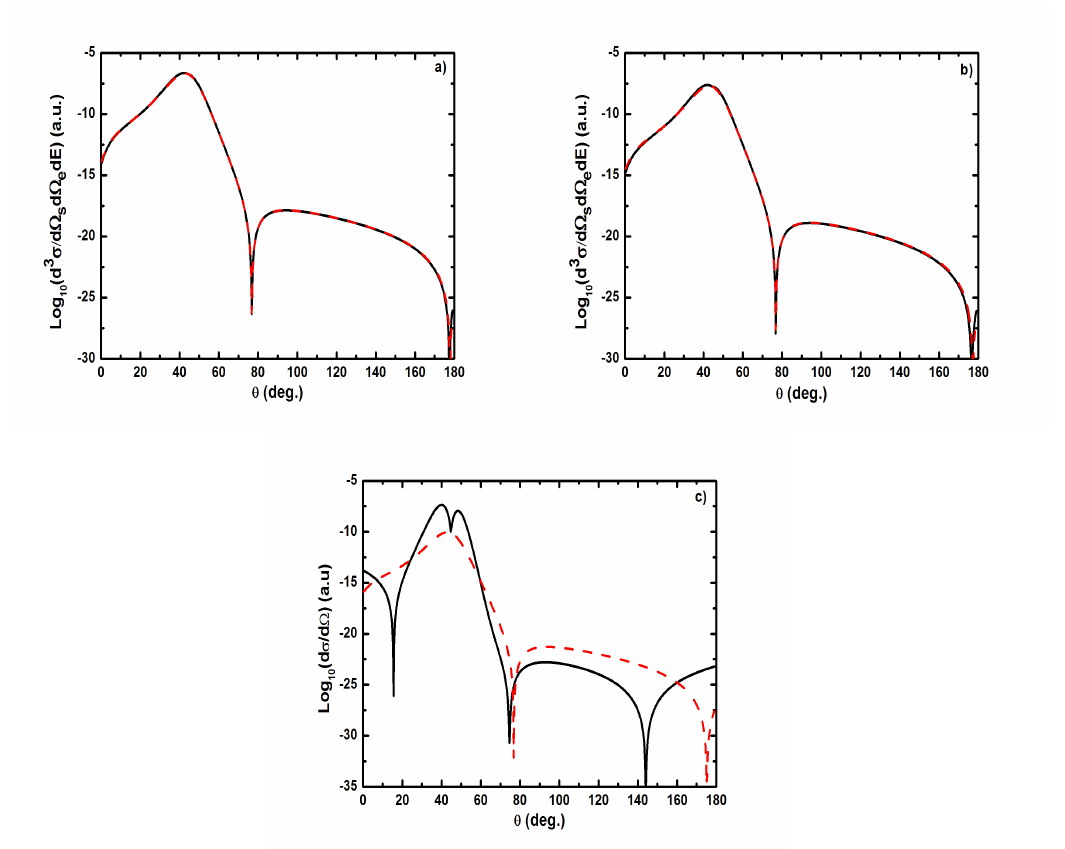
Figure 27. All the parameters are the same as Figure 26, but the laser polarization vector is taken to be perpendicular to the incident momentum k i